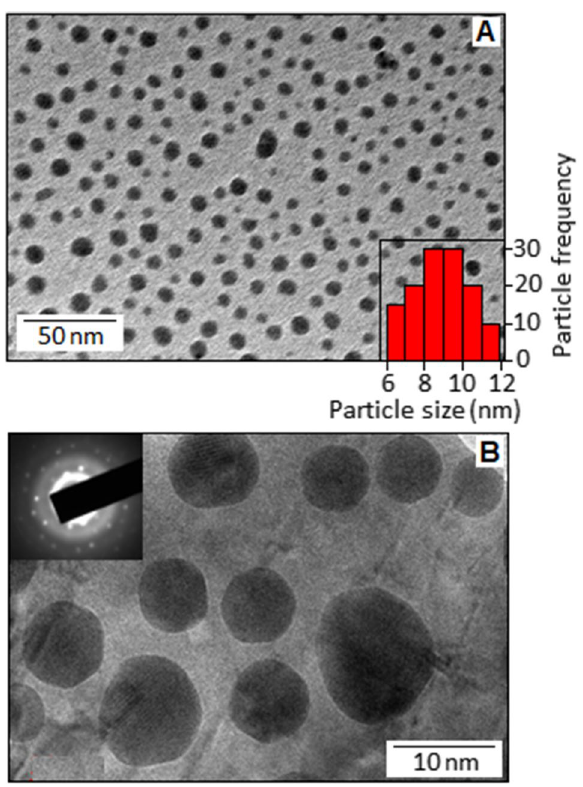
Figure 1. The transmission electron microscope images of the fluoroaniline stabilized lead sulfide nanoparticles with different magnifications ( A , B ). The inset image in ( A ) represent the size distribution of the particles and the inset image in ( B ) is the selected area electron diffraction pattern of lead